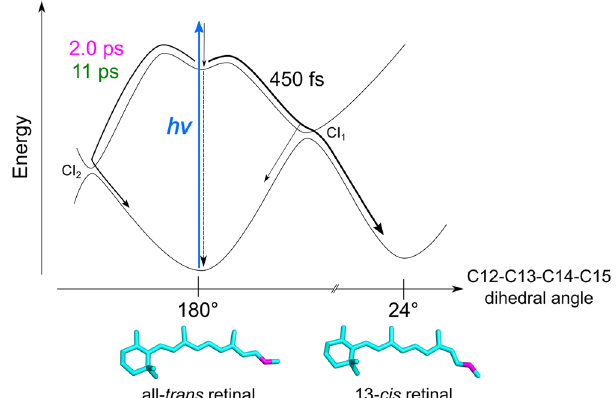
Figure 6. Energy diagram on excited-state dynamics of C1C2. After photon absorption, two distinct paths are suggested on the excited-state dynamics: isomerization path via CI 1 with 450 fs and relaxation path to the initial ground state via CI 2 with 2.0 ps and 11